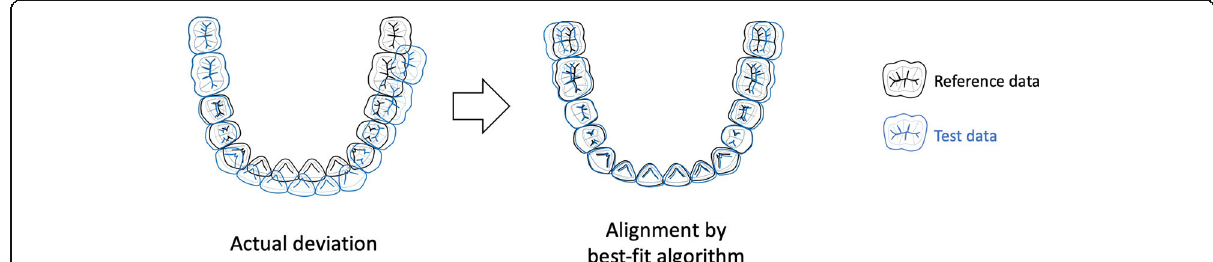
Fig. 4 Schematic image showing positional shift of test data towards reference data through a best-fit algorithm. Due to its calculation methodology, the best-fit algorithm aligns test data with the reference data as closely as possible to its theoretical counterpart. Therefore, the actual positional relationship between the reference data and test data may deviate much more, and the deviation between the images may be